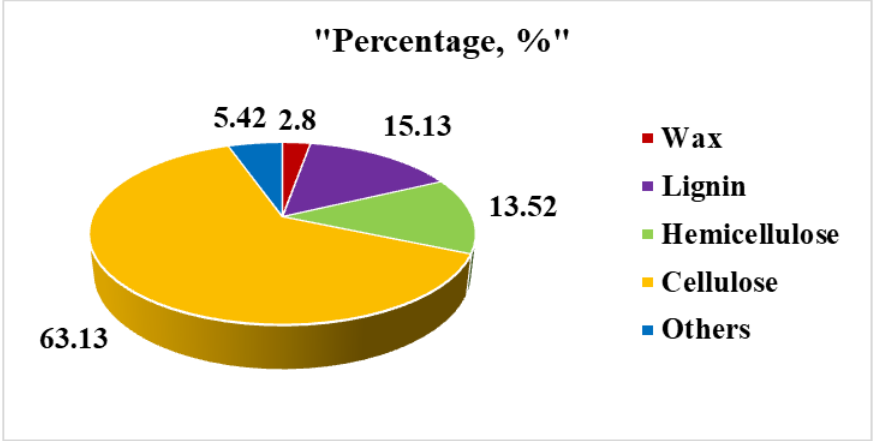
Figure 2. Pie chart showing the chemical composition of GOFs fibers via a gravimetric analysis. Table 1. Comparison of the chemical composition of some important agroforestry waste.